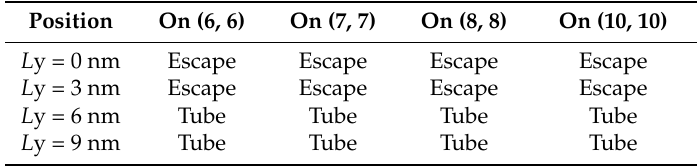
Table 2. Final states of the BP nearby different CNTs at different values of L y, but the same α = 30 ◦ . “Escape” means the tube cannot capture the BP ribbon.